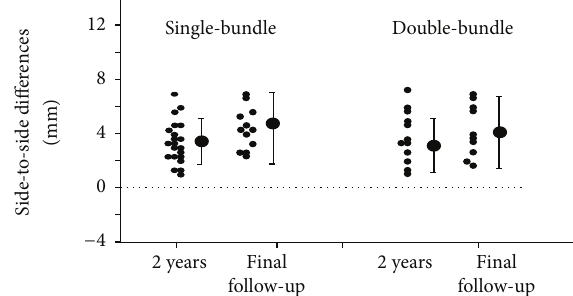
Figure 5: This graph shows the side-to-side differences by knee arthrometry at 133N (30 pounds) in the knee at 70 ∘ flexion. The data represent operated side values minus the opposite side. There were no significant differences between single- and double-bundle procedures or between results at 2 years and > 10